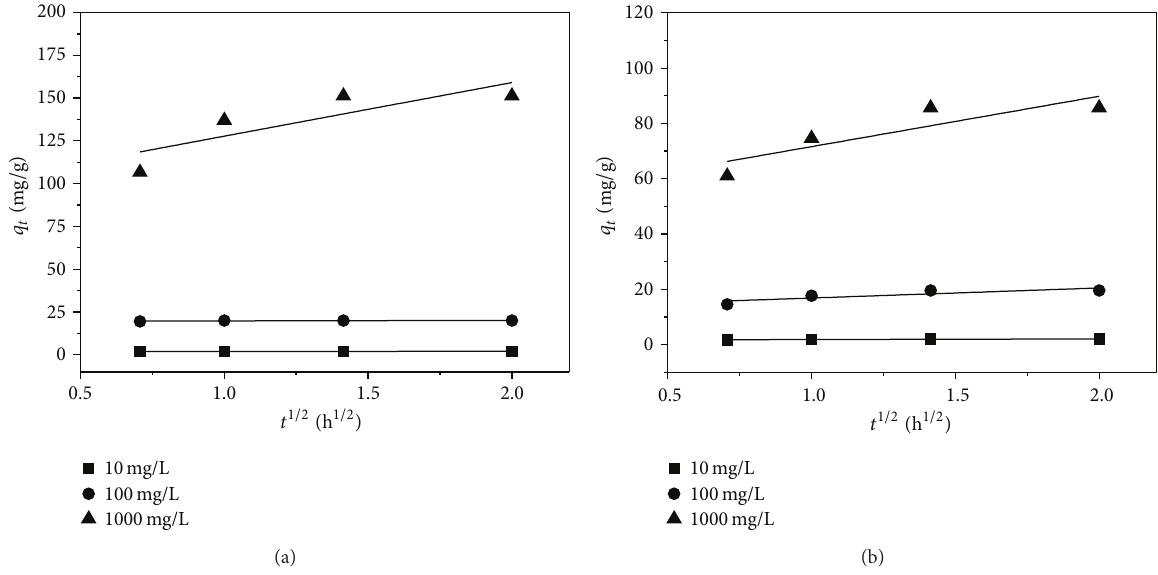
Figure 8: Intraparticle diffusion model for adsorption of (a) Pb 2+ and (b) Cd 2+ on 30/70 HAp/chitosan hybrid fibers at initial metal ion concentration of 10mg/L (square), 100mg/L (circle), and 1000mg/L (triangle).